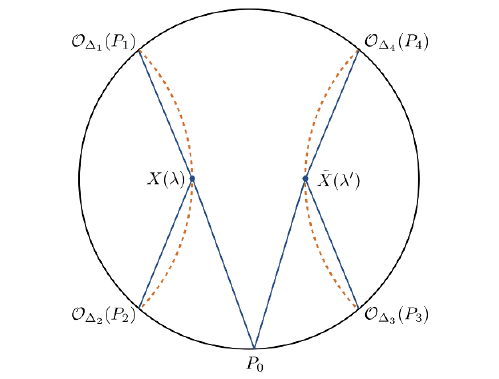
Figure 2 . Cutting the four point scalar geodesic Witten diagram into the three point